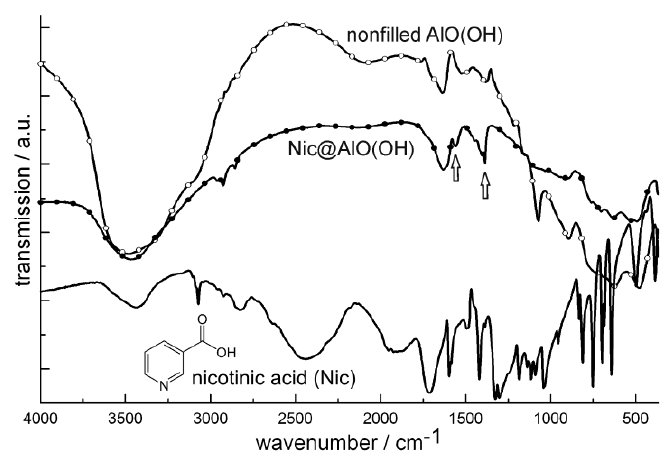
Figure 20. FT-IR spectra of Nic@AlO(OH) (vibrations of nicotinic acid indicated by arrows; nonfilled AlO(OH) hollow spheres and nicotinic acid as